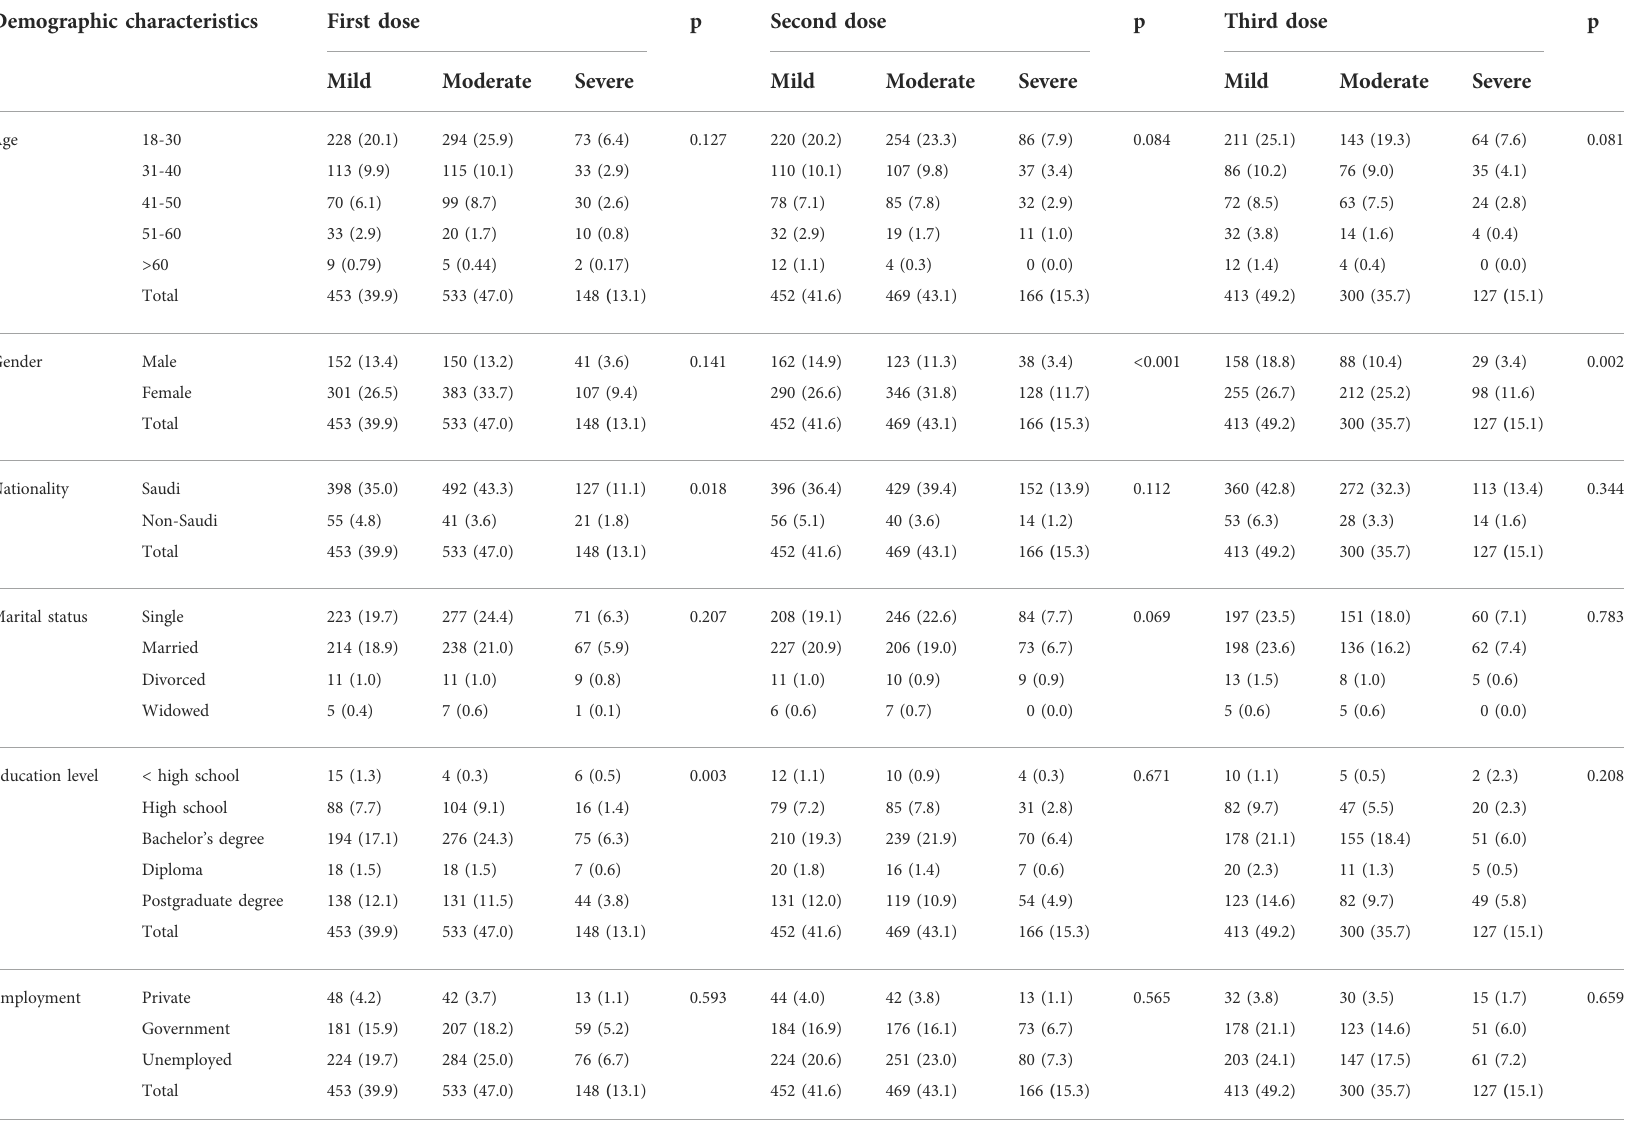
TABLE 5 Correlation between vaccine-related adverse events and the participants ’ demographic characteristics. Demographic